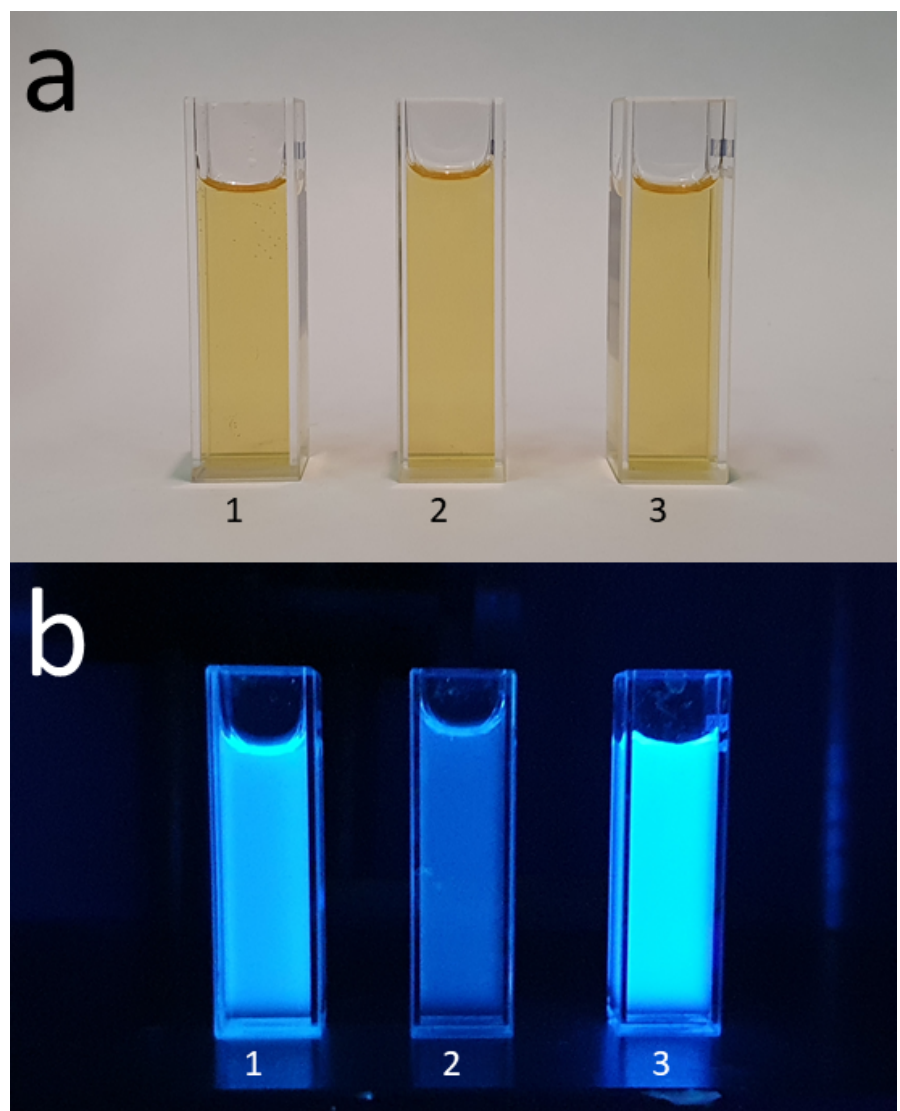
Figure 1. Photographs of UFQD sensing solution at a concentration of 50 µ M: (1) pure and (2) after addition of Pb 2 + or (3) Cd 2 + at a concentration of 100 µ M taken under visible light ( a ) and 365 nm UV light ( b ). The quantum yield (QY) of UFQD decreased to 45% after addition of Pb 2 + and increased by 110 % after addition of Cd 2 + ,